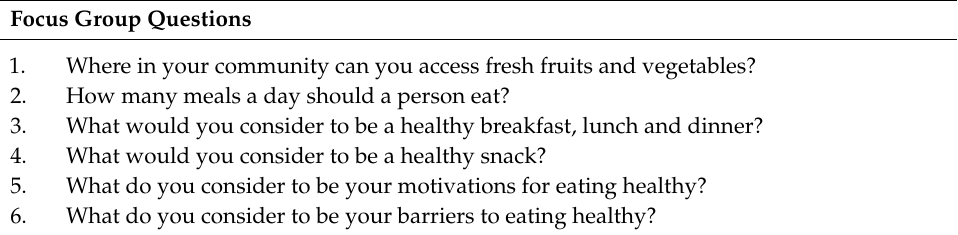
Table 1. Focus group